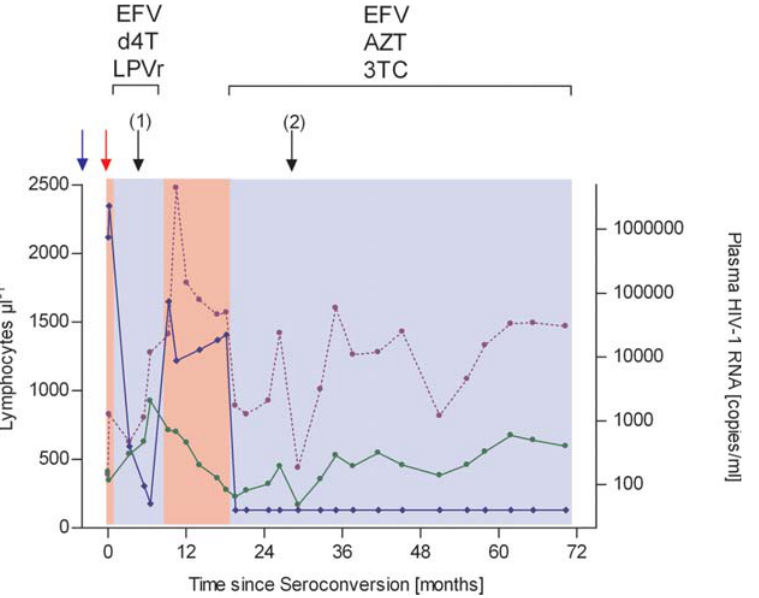
Figure 3. Clinical, immunological and viral load characteristics in an HIV-infected patient homozygous for the CCR5 D 32 deletion (patient # 12). Antiretroviral therapy was initiated twice, eight days after diagnosis with efavirenz (EFV), stavudine (d4T) and lopinavir-ritonavir (LPVr) and again, following rapid disease progression, 18 months after diagnosis with Efavirenz and Zidovudine (AZT) plus Lamivudine (3TC). Unbroken line with closed circles: CD4 + T-cell counts. Unbroken line with closed diamonds: Plasma viral loads. Broken line with closed circles: CD8 + T-cell counts. Blue arrow: negative HIV-1 antibody test. Red arrow: positive HIV-1 antibody test. Black arrows: Proctitis (1) / Shigellosis (2).